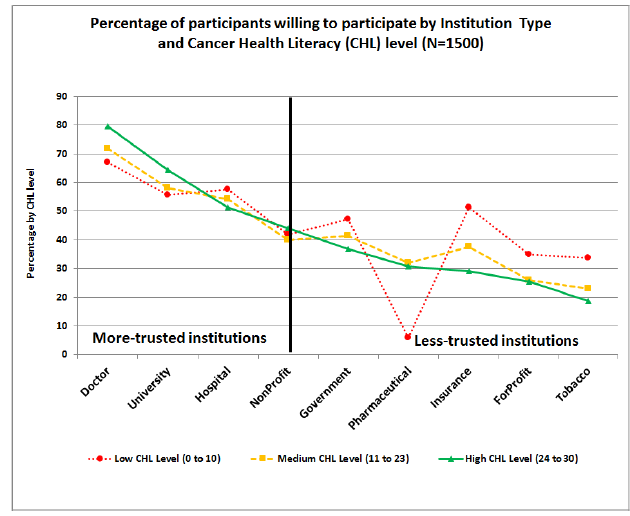
Figure 8. Item-level differences on willingness to participate in research by Institution Type scale and Cancer Health Literacy level.